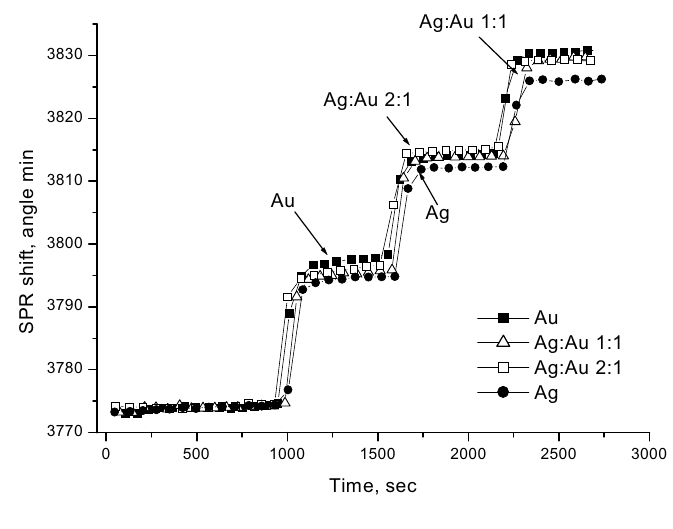
Figure 2. SPR response for various (BI)metallic layers as a result of changes in the refractive index of ambient liquid. Solutions of sodium chloride with increasing concentrations were used, every concentration step resulted in an increase of the refractive index for